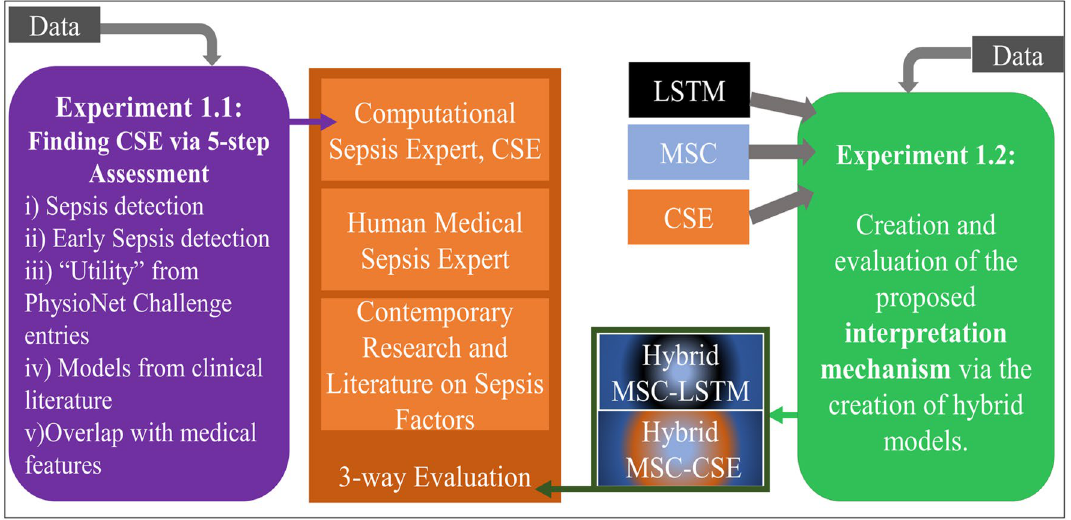
Figure 2. An overview of our approach. Experiment 1.1 is conducted to establish a, computational sepsis expert (CSE) to act as a benchmark in identifying the features a machine needs to “see” to be a good diagnostic model for sepsis. Experiment 1.2 is where we create and assess the proposed interpretation